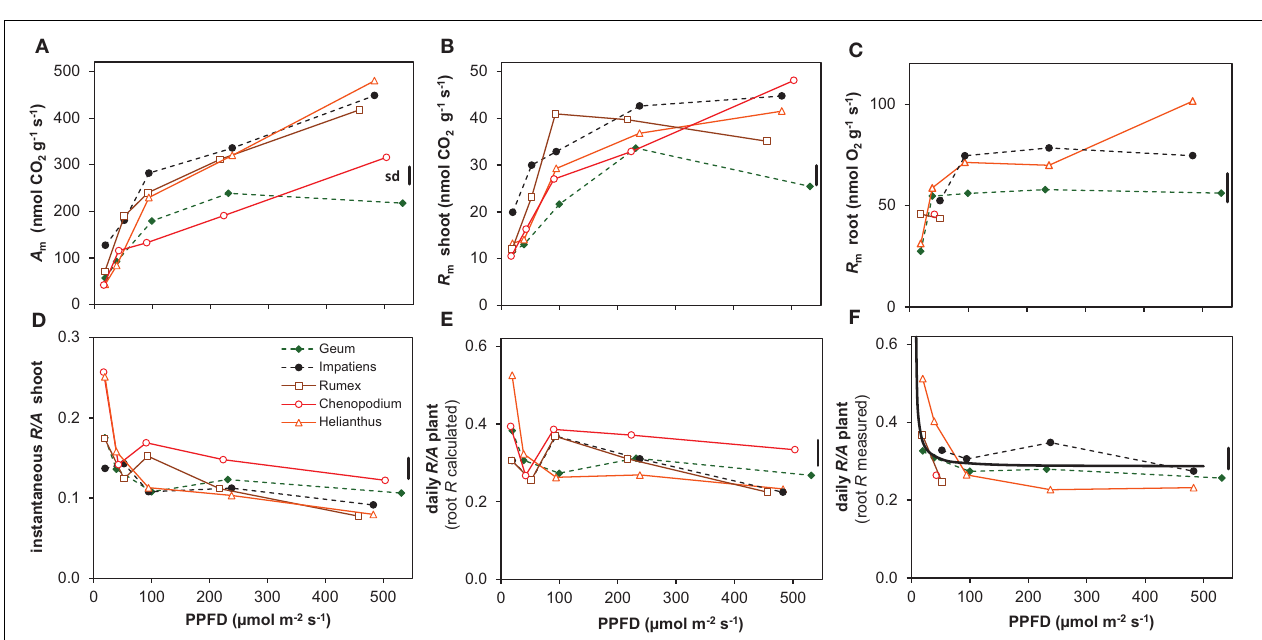
FIGURE 5 | Photosynthesis ( A ) and respiration ( R ) and the ratio between the two ( R/A ) of the five species grown at different irradiances (PPFD). (A) Rates of net CO 2 assimilation at the growth irradiance of whole shoots per unit shoot dry mass ( A m ); (B) release of CO 2 in darkness of whole shoots per unit shoot dry mass (dark respiration; R m ); (C) root respiration measured as the rate of O 2 consumption per unit root dry mass ( R m ); (D) shoot R/A